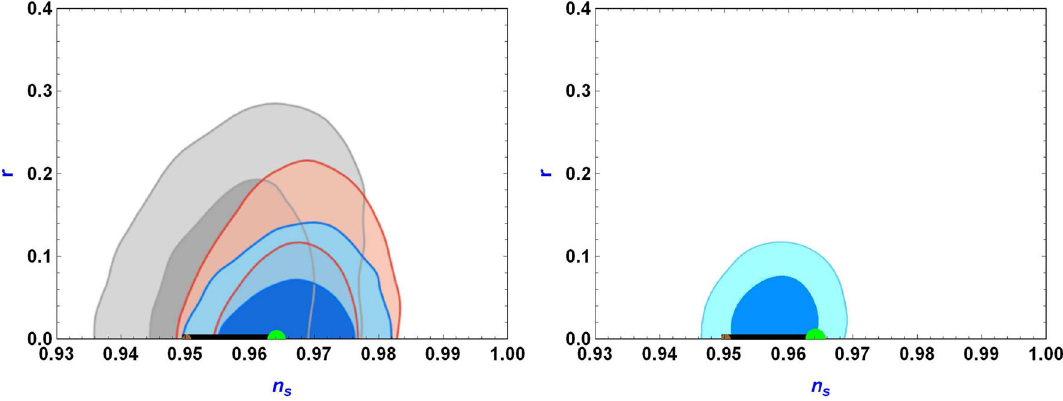
Fig. 1 The r – n s diagram comparing the predictions of the non- comoving warm inflation model in the weak regime with power-law scale factors, having the model parameters of Table 1, with the observa- tional dataof thePlanck2013, 2015 and 2018 data sets.In the leftpanel, the likelihood of Planck 2013 are indicated with gray contours, Planck TT+lowP with red contours, and Planck TT, TE, EE+lowP (2015) with